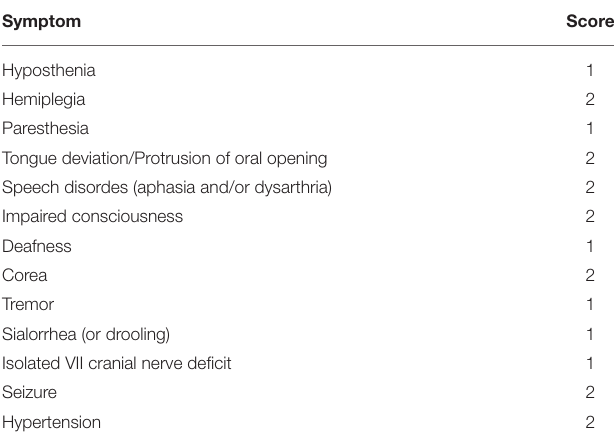
TABLE 1 | Severity score for each symptom observed. Symptom